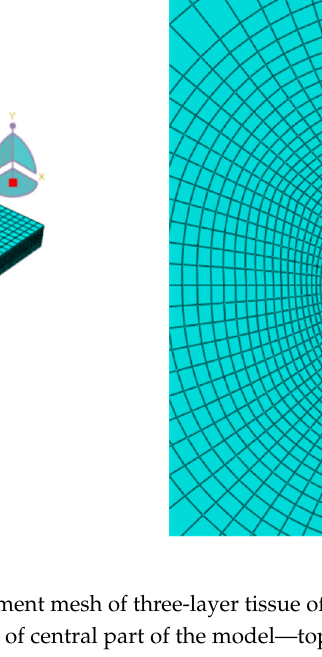
Table 1. Hyperelastic and elastic parameters for the tissue of animal origin